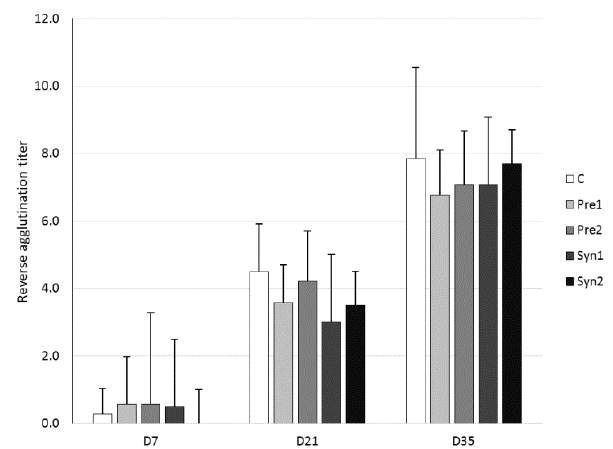
Figure 3. Serum reverse agglutination titer (mean ± SD) against SRBC: C – control, Pre1 – prebiotic 1, Pre2 – prebiotic 2, Syn1 – synbiotic 1, and Syn2 – synbiotic 2.